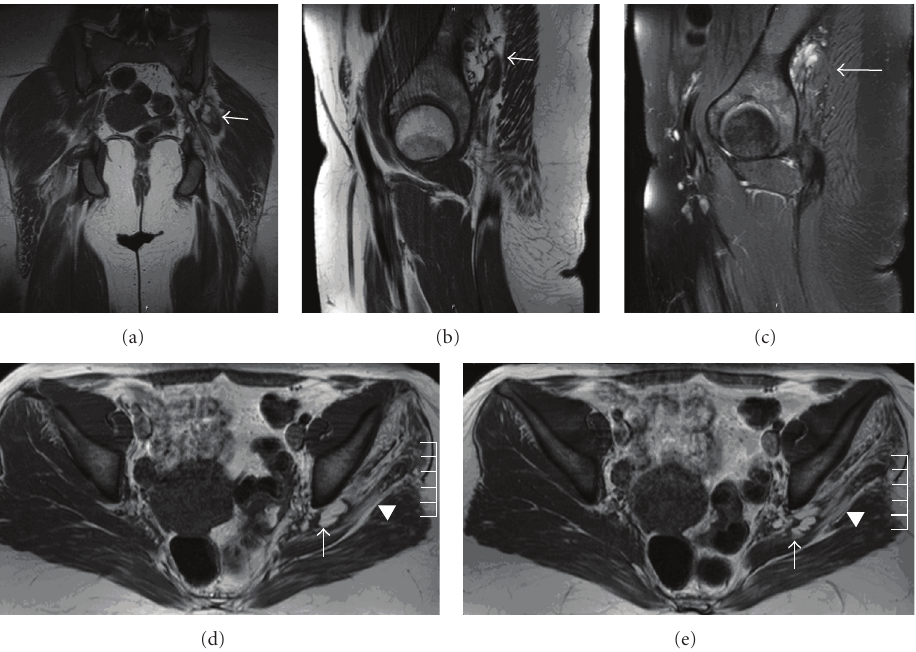
Figure 1: T1 (coronal (a), sagital (b), axial (d), and (e))—and T2 fat saturated (sagital (c))—weighted images of the left pelvis and hip. There is a 2 . 9 × 3 . 4 × 3 . 2cm lobulated mass involving the sciatic nerve at the sciatic notch (arrow). It is hyperintense on T1 and T2 fat saturated images. Adjacent musculature, gluteus medius, and gluteus minimus are atrophic and have edematous changes (arrowhead).